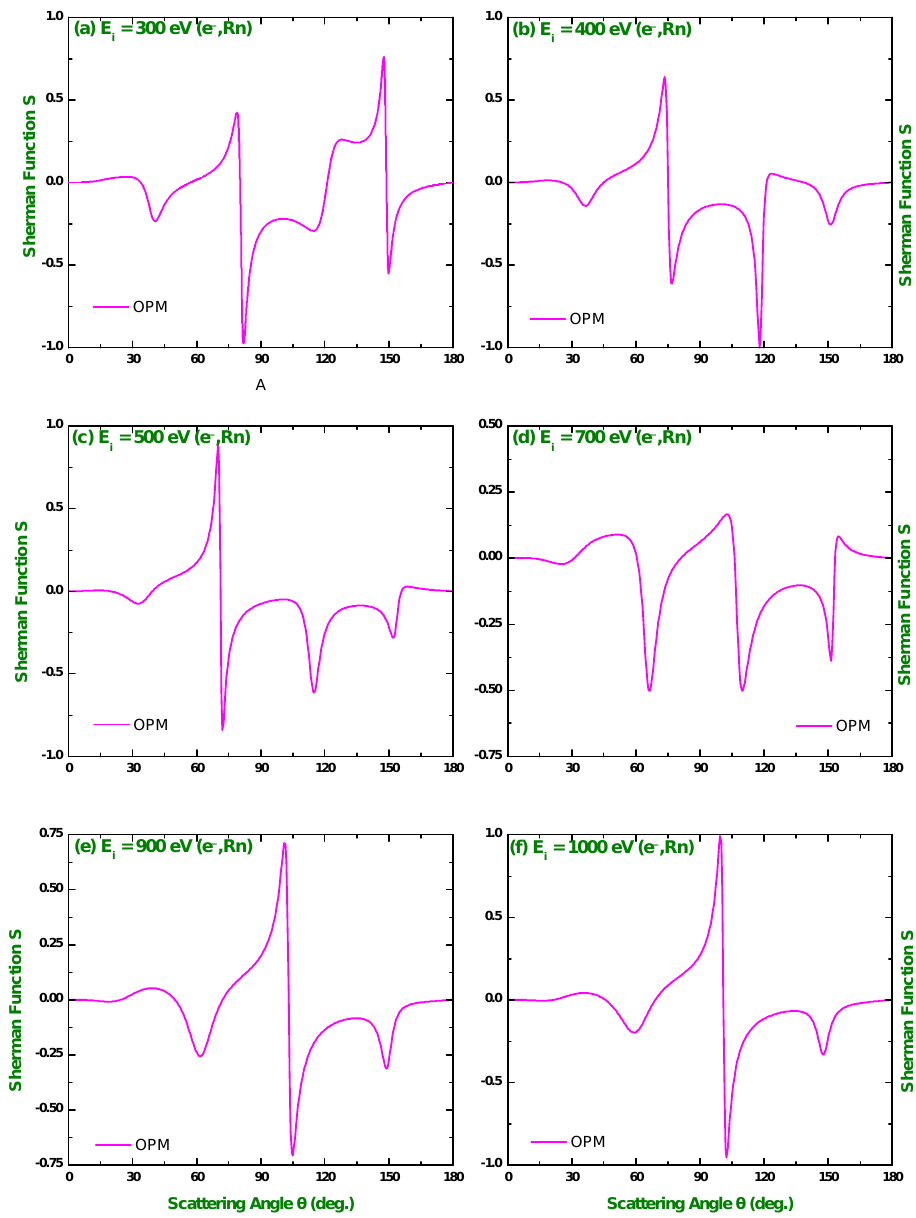
Figure 12. Same as Figure 10, but at impact energies of 300, 400, 500, 700, 900 and 1000 eV. Figure 13 displays the energy dependence of the DCS and Sherman function of the elastic e − - 222 Rn scattering over the energy range 1 eV ≤ E i ≤ 1 MeV at two forward scattering angles ( θ = 30 ◦ and 90 ◦ ) and one backward angle ( θ = 150 ◦ ). This figure (panels a, c and e) clearly demonstrates that strong R-T structures are present in the DCSs at all scattering angles for kinetic energies E i < 3 keV. It is also revealed that the R-T structures gradually fade out as E i approaches towards the M-subshells binding energies (3–4.6 keV [40]). Beyond 3 keV, the DCS declines monotonously with E i . This is expected because the pure Coulomb field of the nucleus dominates in this energy